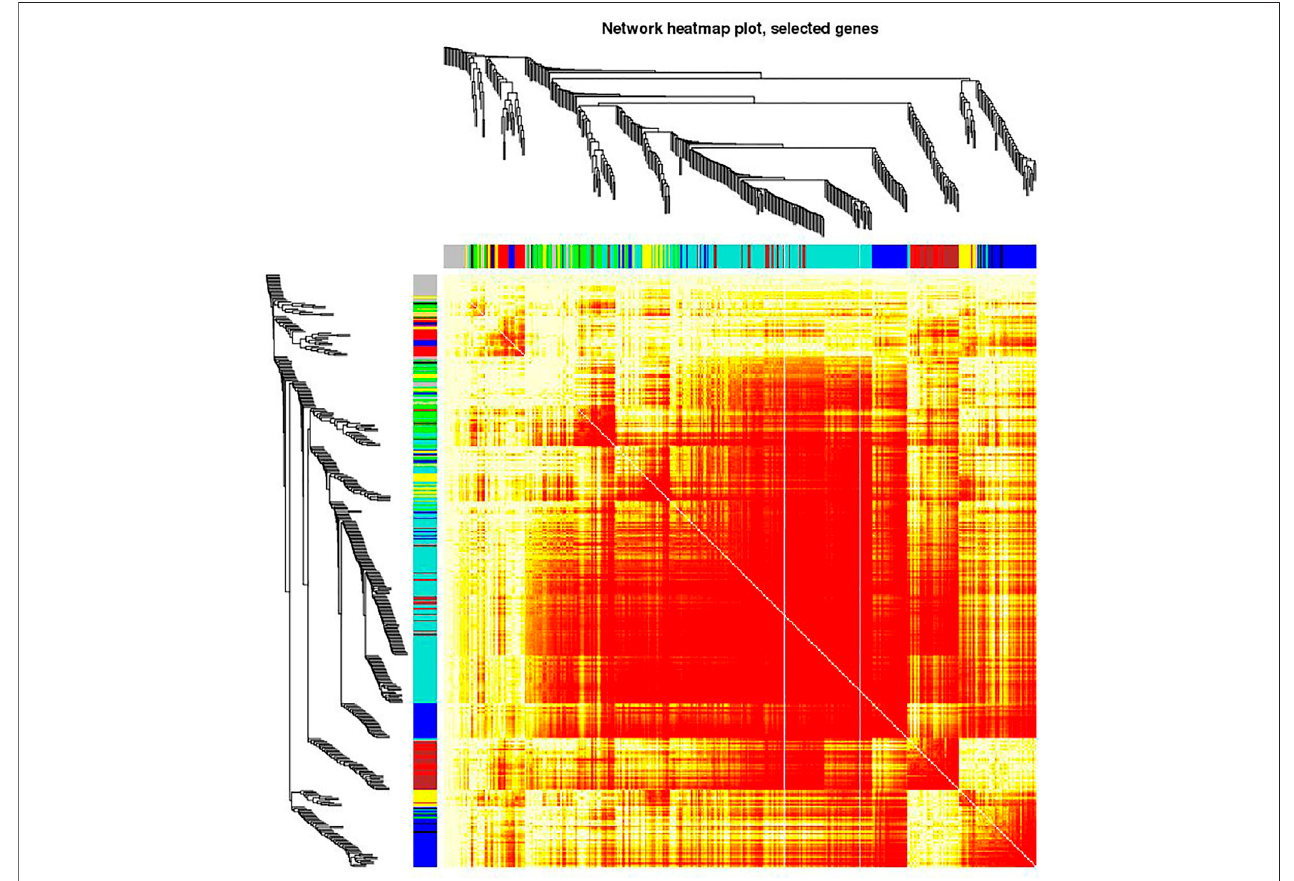
FIGURE 5 | Visualizing the gene network using a heatmap plot. The heatmap depicts the Topological Overlap Matrix (TOM). The light red color represents low overlap and progressively darker shades of red represent higher overlap. Blocks of dark colors along the diagonal depict modules. The gene dendrogram and module assignment are also shown along the left side and the top of the